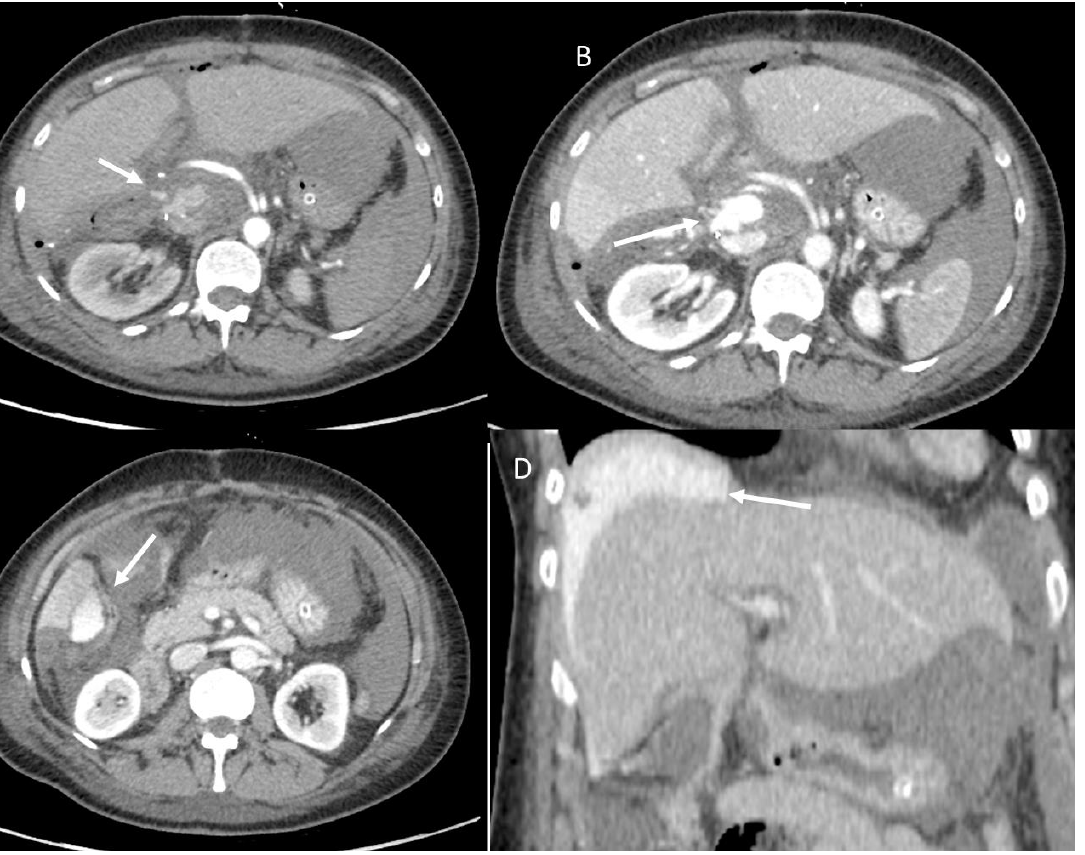
Figure 5. Active bleeding (arrow) during arterial ( A ), portal ( B ), and late ( C ) phase of contrast study. In ( D ), arrow shows contrast collection in perihepatic space.